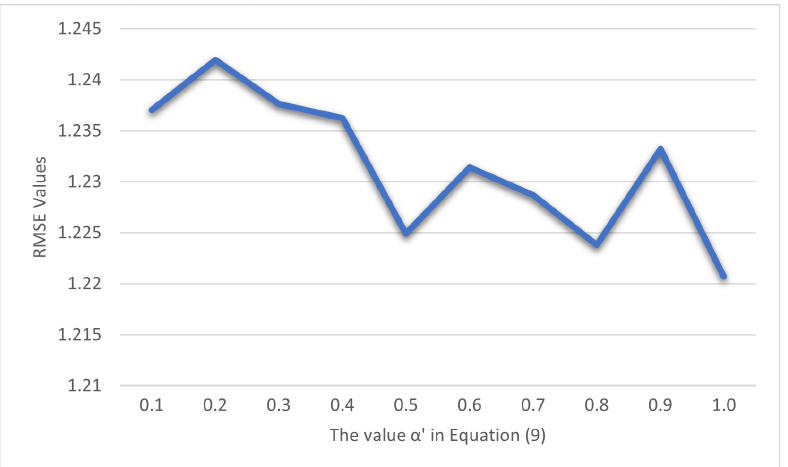
Figure 9. The impact on the average RMSE value from changes on α (cid:48) in Equation (9) (Champaign- Urbana). The α (cid:48) indicates the weight of geographical similarities among the users played in the affinity matrix S